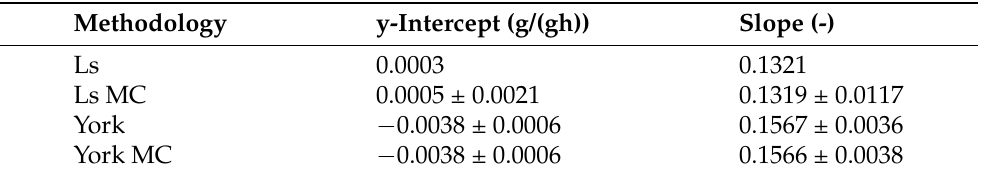
Table 2. Summary of the resulting regression parameters of the analyzed E. coli fed-batch processes with the standard parameter error for least squares (Ls) and York regression, with and without Monte Carlo (MC) resampling.